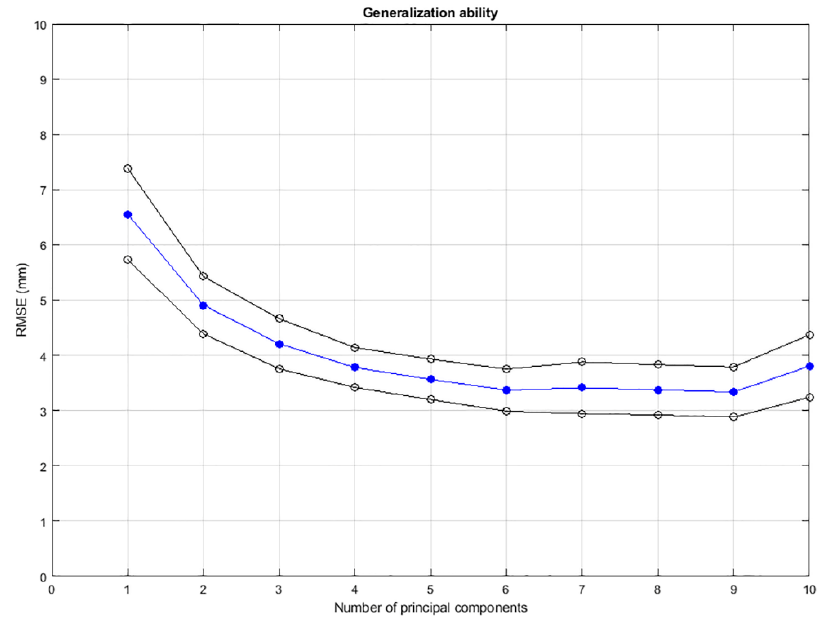
Figure A1. Graph of the generalization ability of the statistical shape model (SSM) by means of the leave-one-out method. The blue dots represent the root mean square error (RMSE, mm) of the reconstructed and actual shapes of n − 1 patients for a given number of principal components (PCs). The open, black dots represent the boundaries of the 95% confidence interval. The mean generalization of the SSM with five PCs is 3.6 (95% CI: 3.2–3.9) mm.